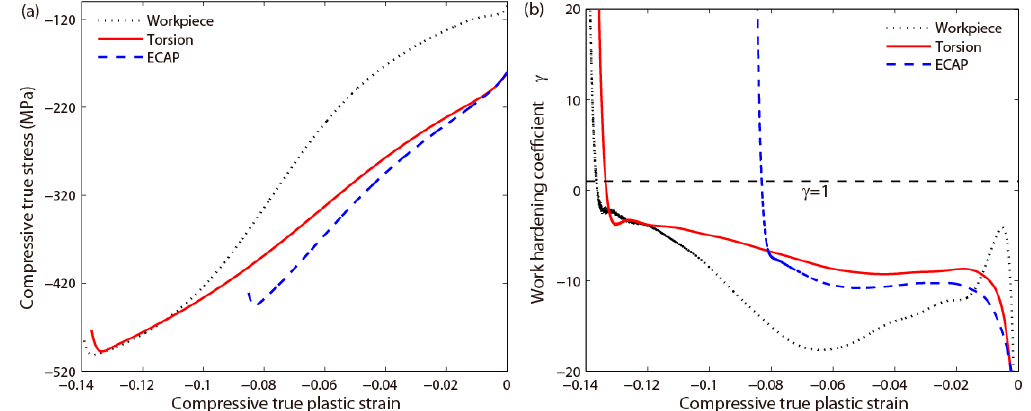
Figure 10. ( a ) Compressive true stress vs. compressive true plastic strain curves for AZ31B processed by different deformation modes; ( b ) work hardening coefficient vs. compressive true plastic strain curves for AZ31B processed by different deformation modes.